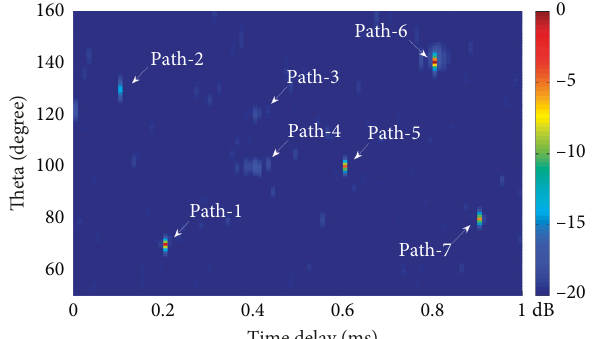
Figure 6: DOA-time-shift spectrum.